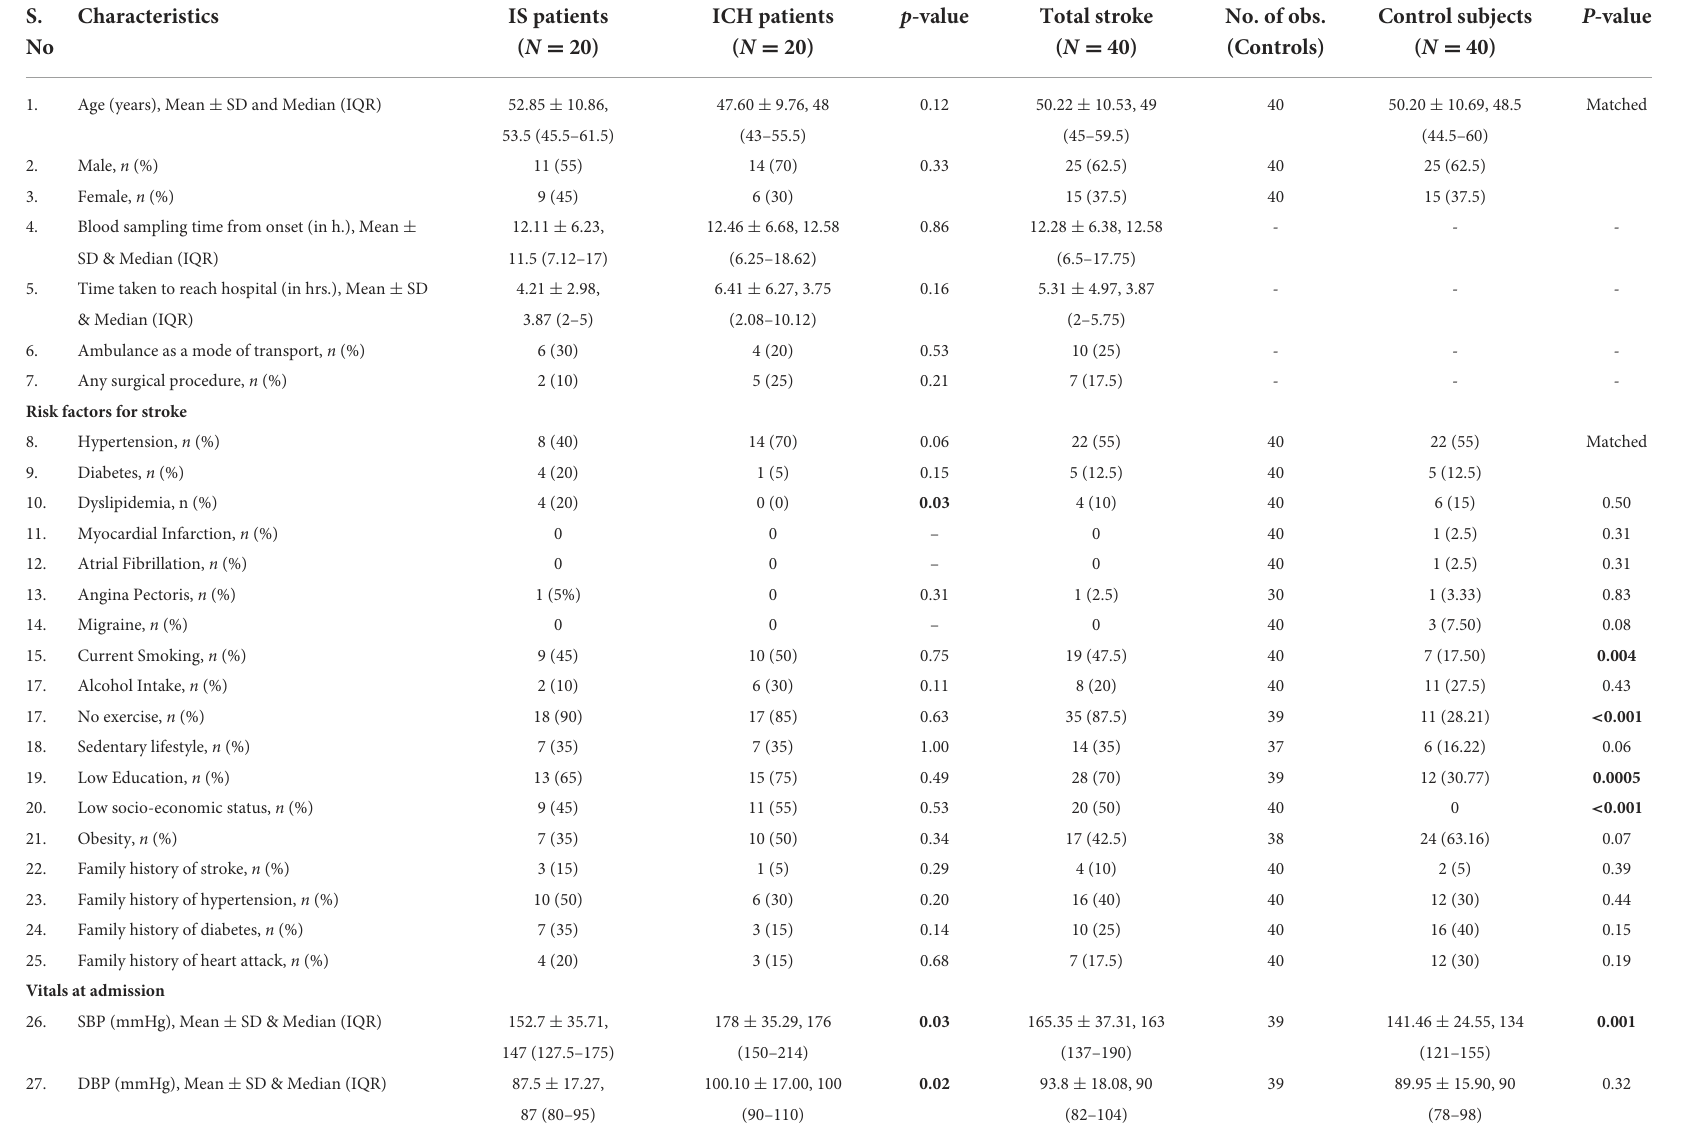
TABLE 1 Baseline characteristics of acute stroke patients and healthy control